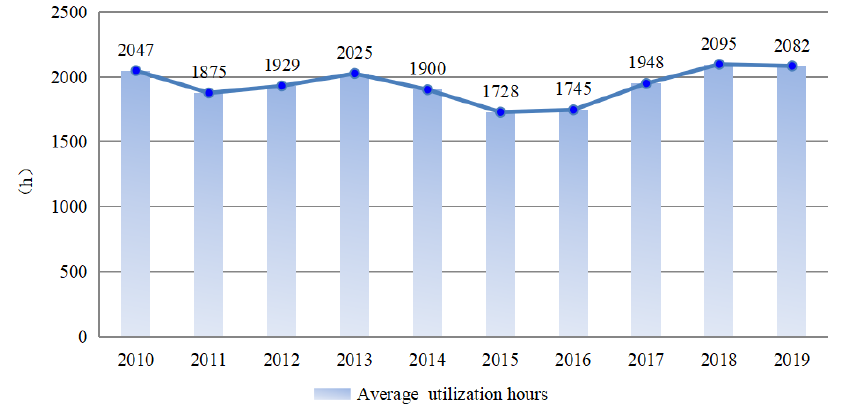
Figure 10. China’s wind power utilization hours in 2010– 2019.